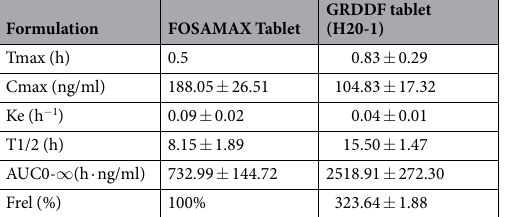
Table 2. Pharmacokinetic parameters of the oral administration of two alendronate formulations with a fixed dose of 17.5 mg to rabbits (mean ± SD, n = 3). GRDDF, gastroretentive drug dosage form; T max , time to